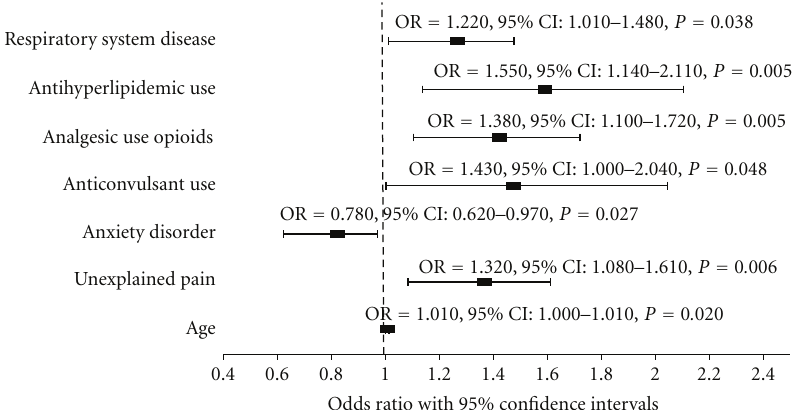
Figure 2: Logistic regression predicting duloxetine or venlafaxine XR at index. (Venlafaxine XR served as the reference group in the model. Only predictors with statistical significance are